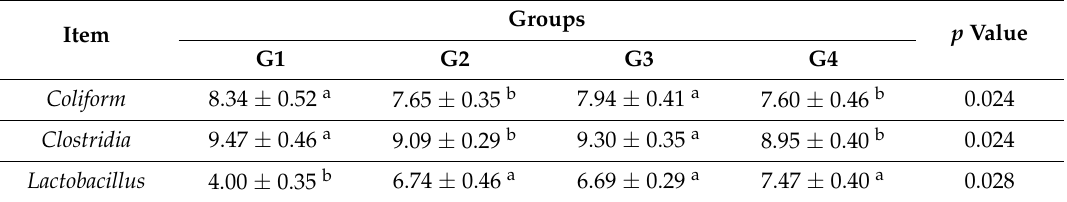
Table 4. Mean fecal counts of coliform, Clostridium , and Lactobacillus at 35 days of age in broiler chickens.